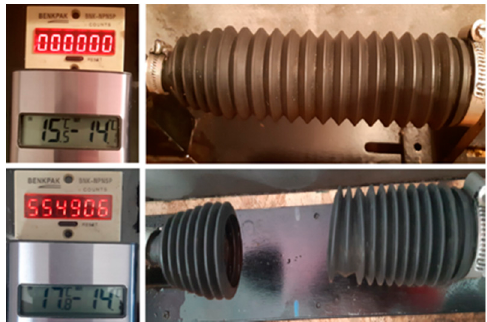
Figure 7. The presentation of a cuff’s state at the start and end of the tests on sample no. 9, which was exploited in the northern region.